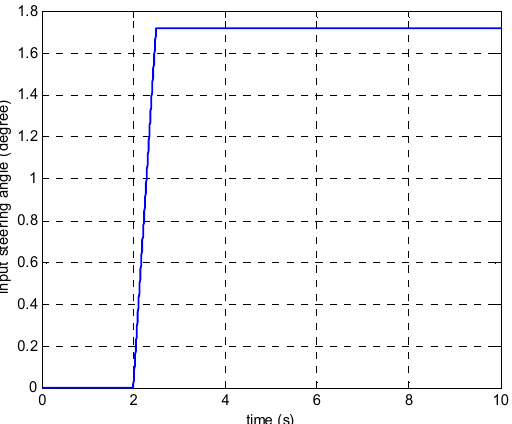
Figure 13. Driver’s input steering angle in the second set of simulations.